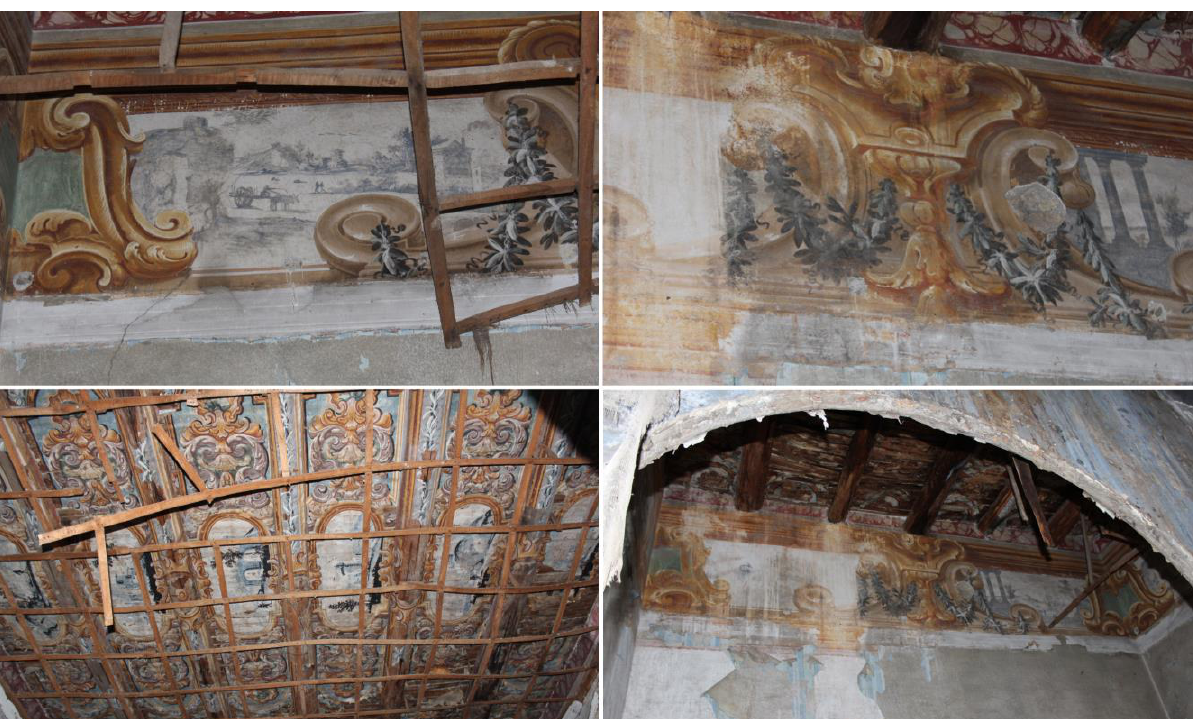
Figure 11. Details of the 18th-century parietal decorations and 'incartate’ that covered the wooden floors of the main floor, later covered by ceilings as part of 19th-century